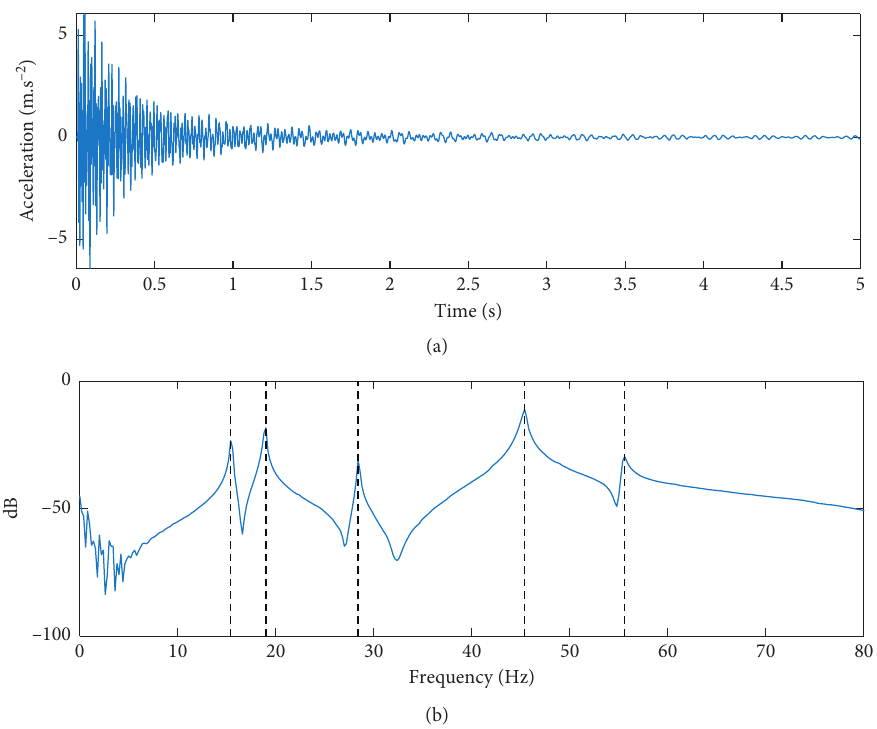
Figure 16: (a) Time history of the wingtip acceleration response and (b) its Fourier spectrum.